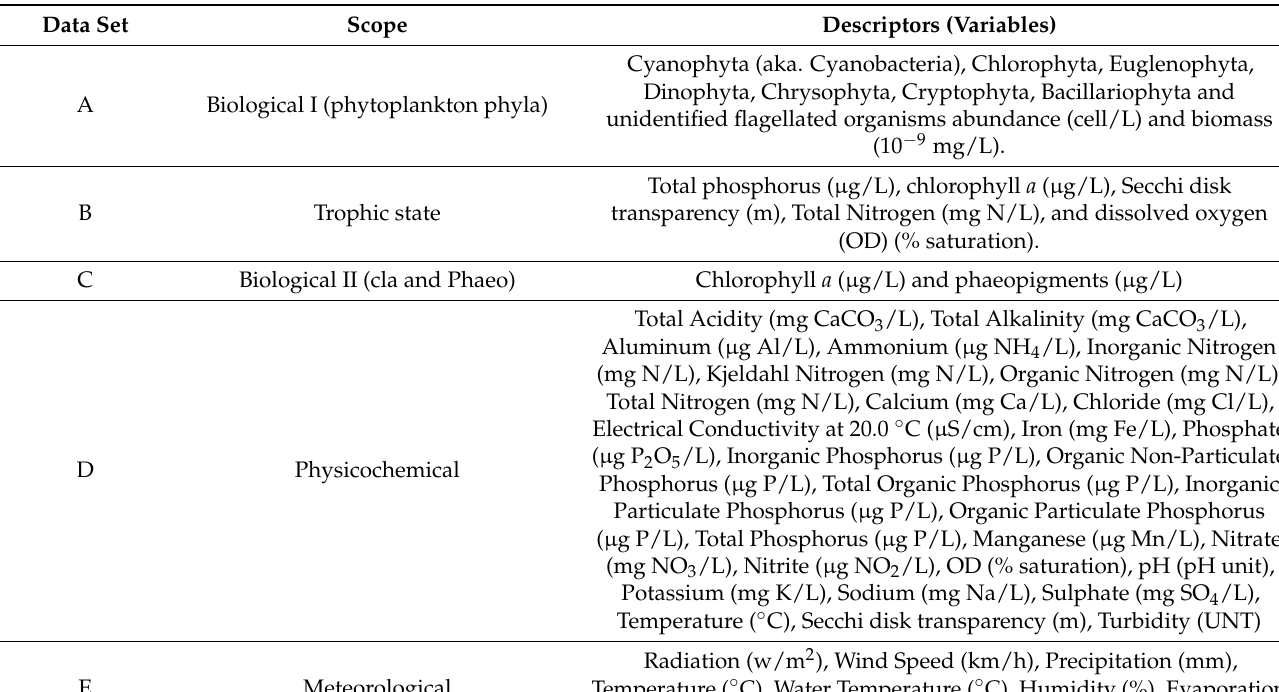
Table 2. The data groups and variables in each